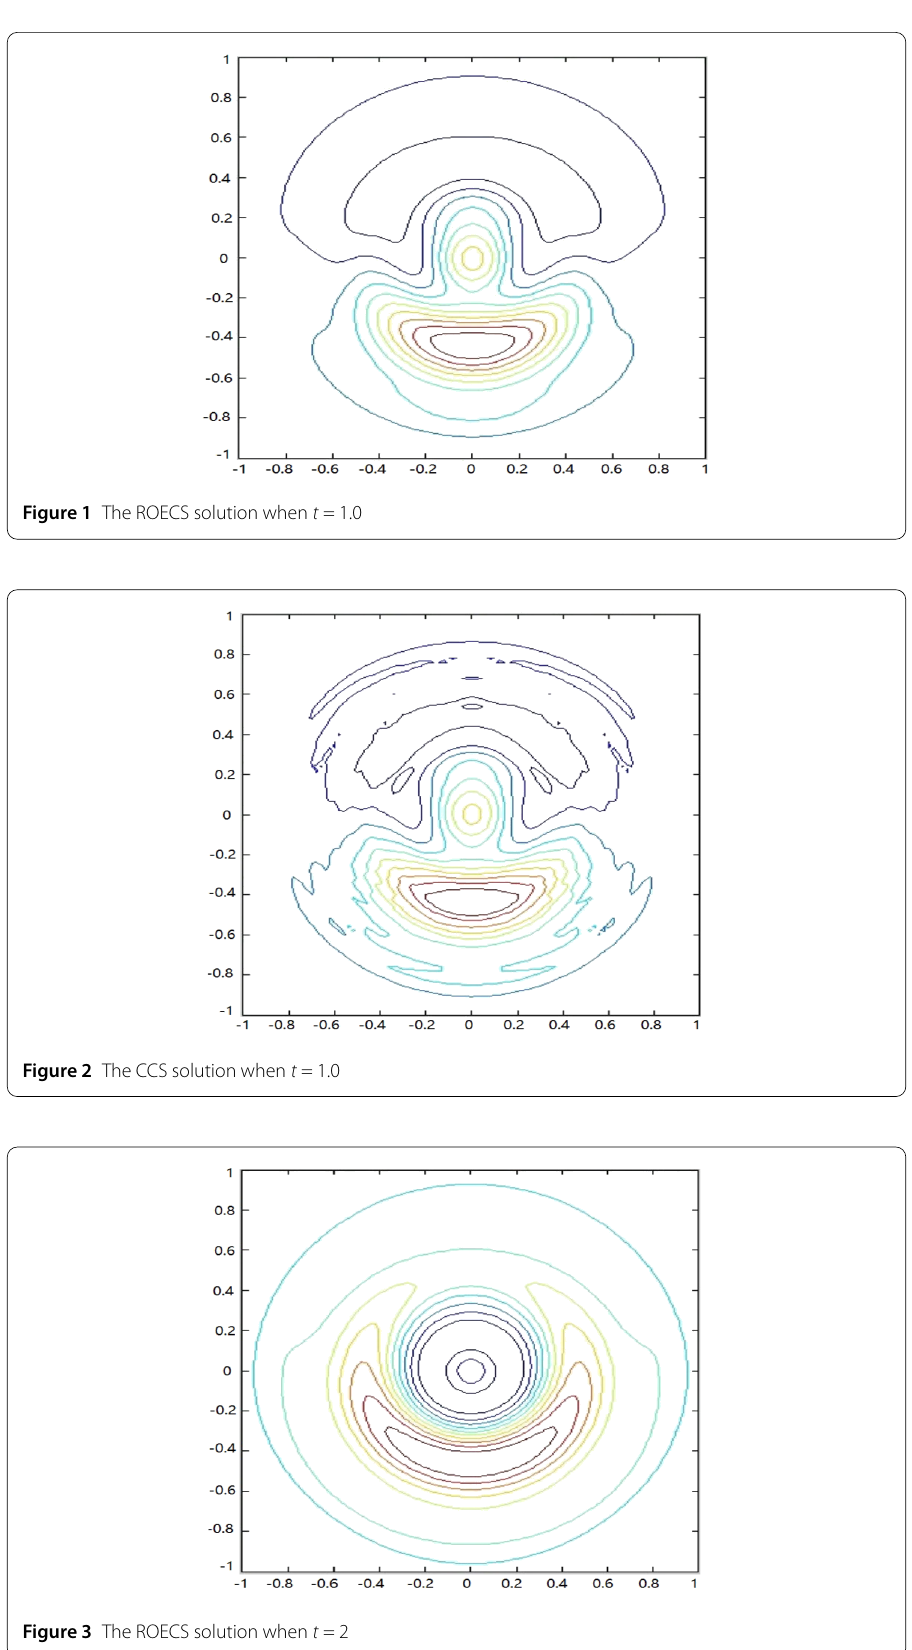
Figure 3 The ROECS solution when t =